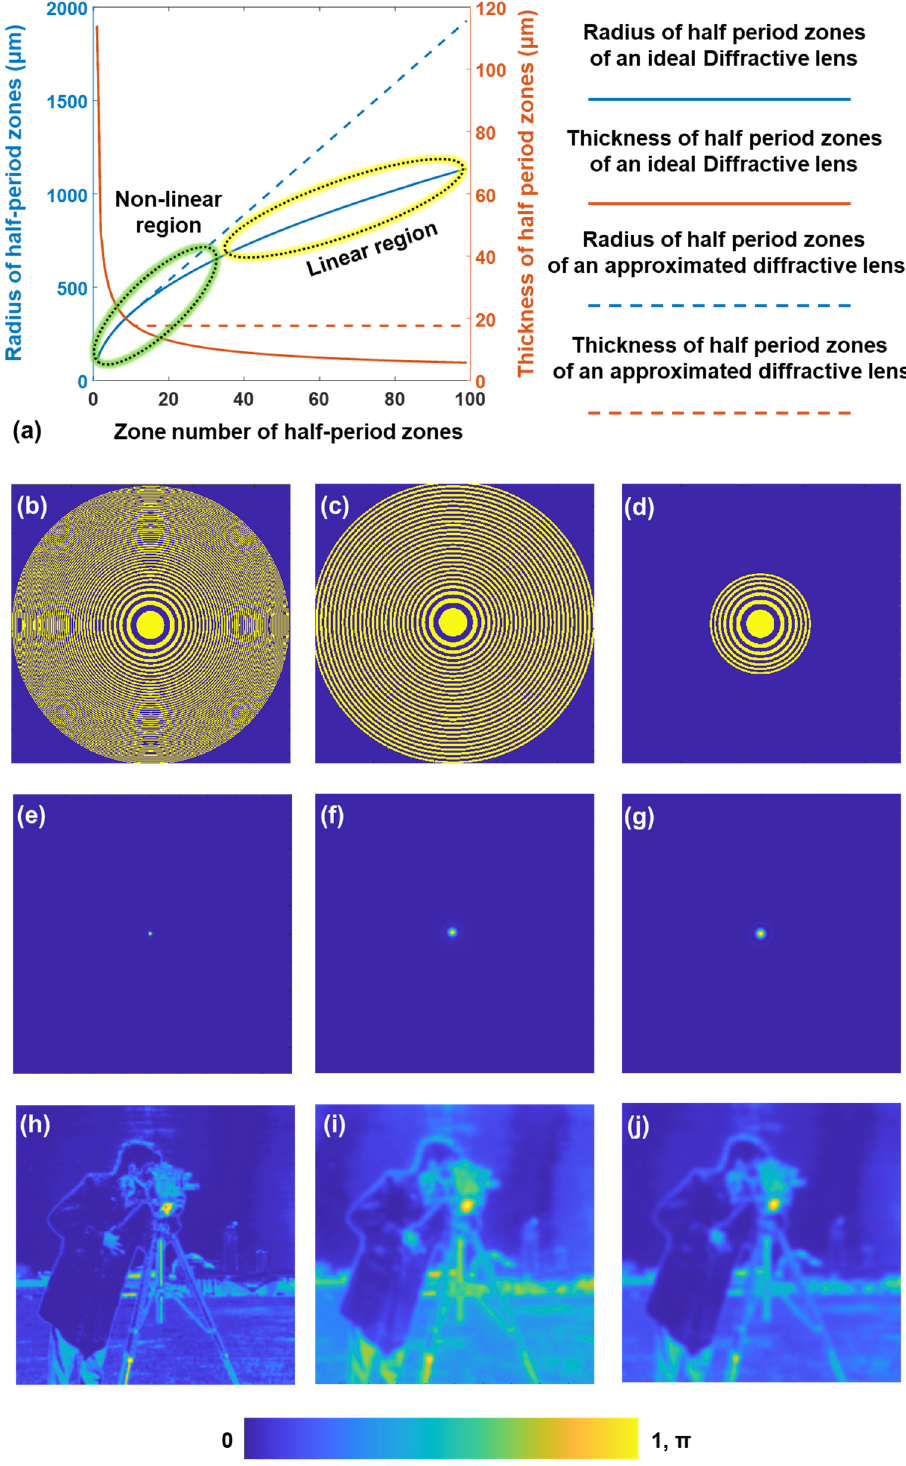
Figure 1. ( a ) Plot of the radius and thickness of zones of an accurate and approximate diffractive lens. Phase image of ( b ) an accurate diffractive lens, ( c ) an approximate diffractive lens and ( d ) a diffractive lens within the lithography limit. PSF of ( e ) an accurate diffractive lens, ( f ) an approximate diffractive lens and ( g ) a diffractive lens within the lithography limit. Imaging results of a test object obtained using ( h ) an accurate diffractive lens, ( i ) an approximate diffractive lens and ( j ) a diffractive lens within the lithography limit.